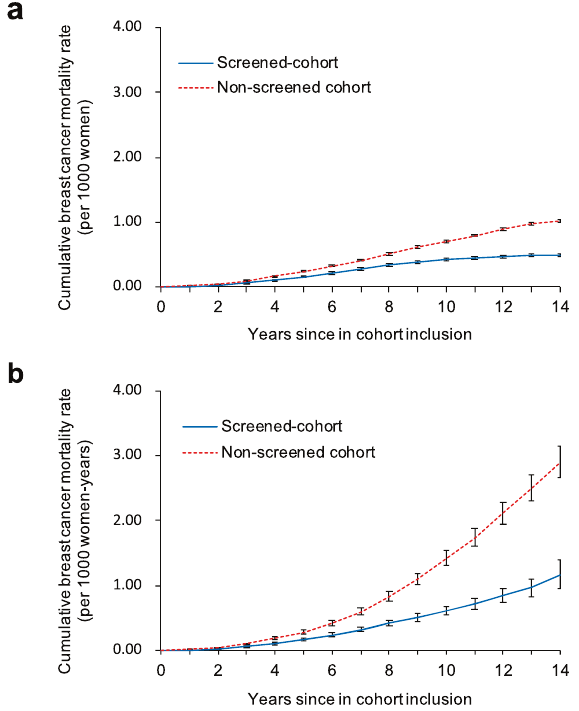
Fig. 2 Cumulative mortality rates between the screened and non- screened cohorts in the KNCSP, 2002 − 2015. a Cumulative mortality rates with 95% con fi dence intervals. b Nelson − Aalen estimates of the cumulative mortality rates with 95% con fi dence